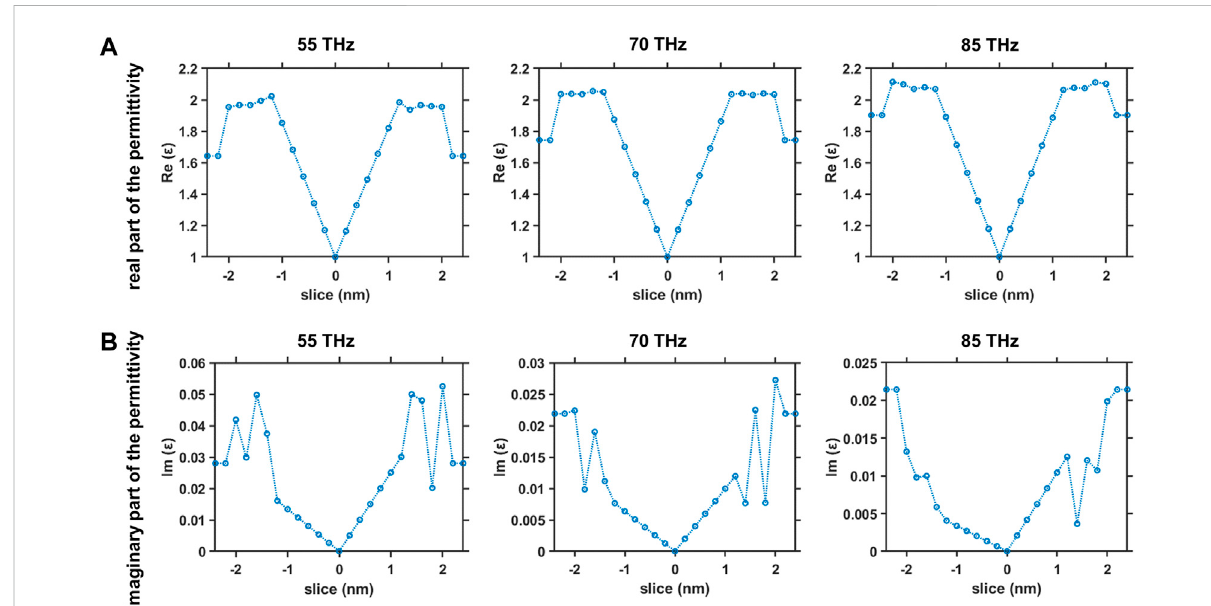
Dielectric properties across the equilibrated membrane-water system at frequencies in the range of 55 – 85 THz (A) Real part of the permittivity versus slice position at55 THz (left), 70 THz (middle) and 85 THz (right) and (B) imaginary part of the permittivity versus slice position at55 THz (left), 70 THz (middle) and 85 THz